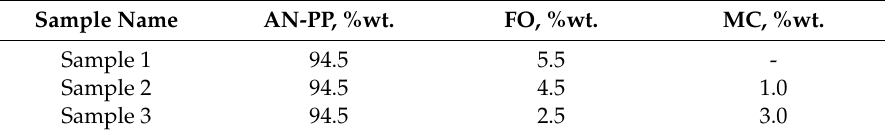
Table 1. Non-ideal explosive compositions,